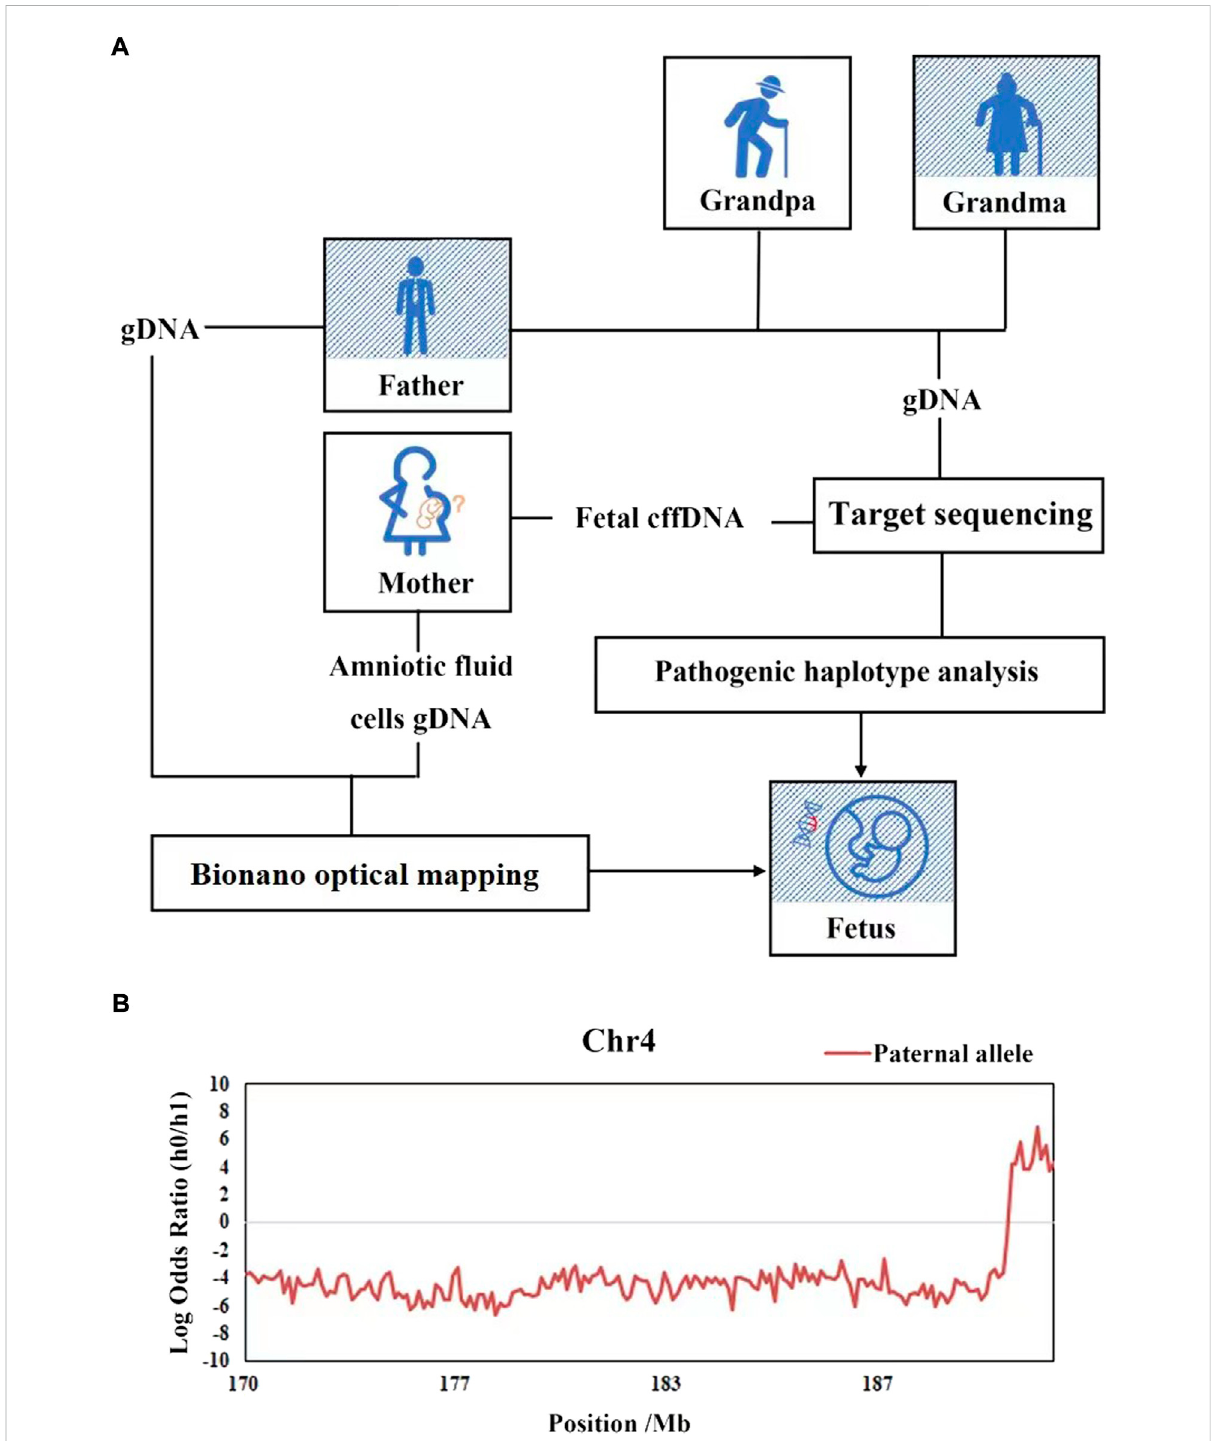
FIGURE 3 Haplotype-based NIPD of the fetus of family FSHD1. (A) Work fl ow of NIPD of FSHD1. (B) The HMM-based prediction of recombination and the predicted fetalhaplotype.The x -axis representslociontarget area, the y -axisrepresentsthelogarithmicvalues oftheoddsratiosoffetal inheritance of the paternal haplotypes, the red lines represent the paternal haplotype of fetal inheritance. The lines above zero (gray line) indicate that the pathogenic allele was inherited (Hap0), while the lines below zero mean the normal allele is inherited (Hap1), there was a recombination event been detected at the